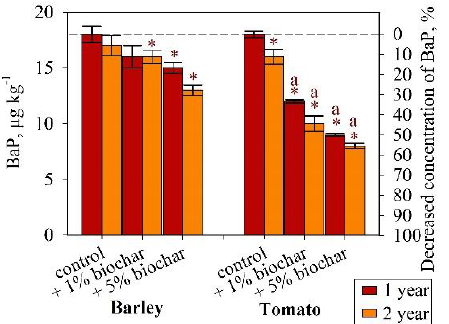
Figure 1. The BaP content in the soil of the control variants of the model experiment with and without the introduction of biochar. Note: * A statistically significant difference in the BaP content in Haplic Chernozem with and without biochar application (control) is noted. The letter “a” shows statistically significant differences between the content of BaP in the soil of pots with barley plants and with tomato plants under the same doses of pollutants and sorbent application conditions. The